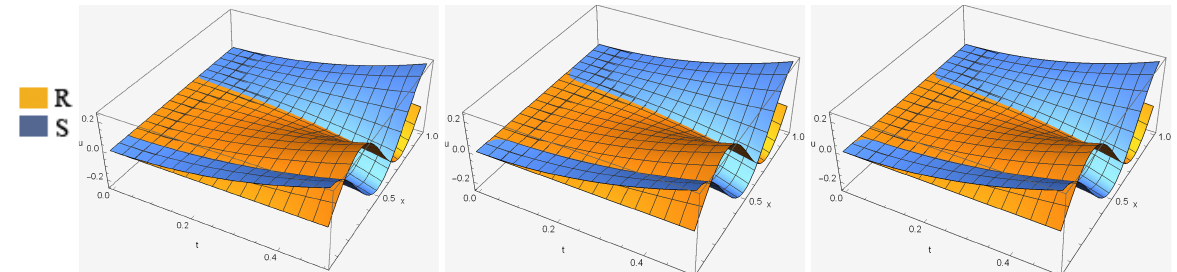
Figure 4. Error graph of R and S in Equation (1) for α = 0.1, α = 0.01, α = 0.001, respectively, τ = 0.005, a = 1, b = 2, N = 78 and t = 1. −